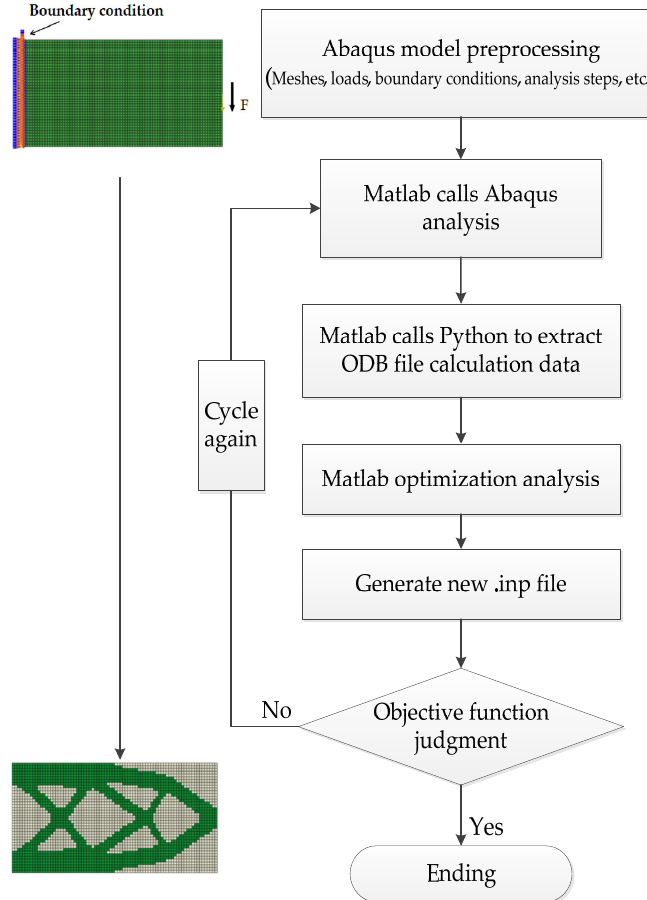
Figure 2. Flowchart of topology optimization.